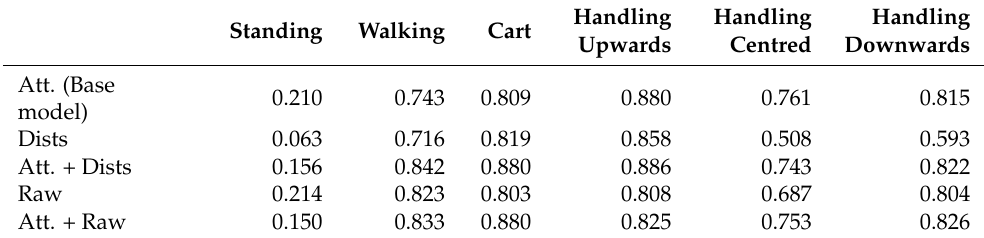
Table 5. Class-wise F1 scores of RF